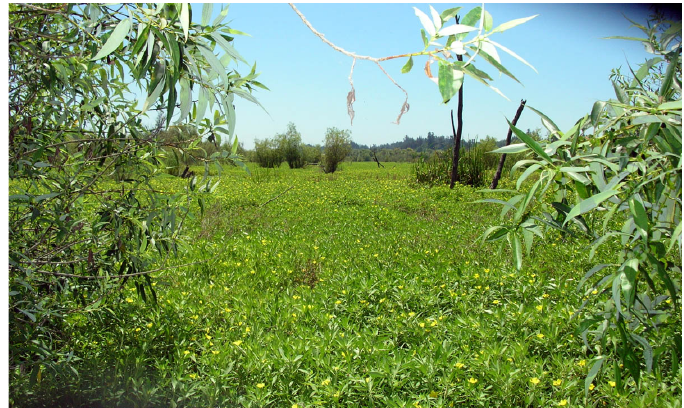
Figure 4. Photograph of Ludwigia hexapetala invasion in Laguna de Santa Rosa wetlands (Sonoma County, California, USA).